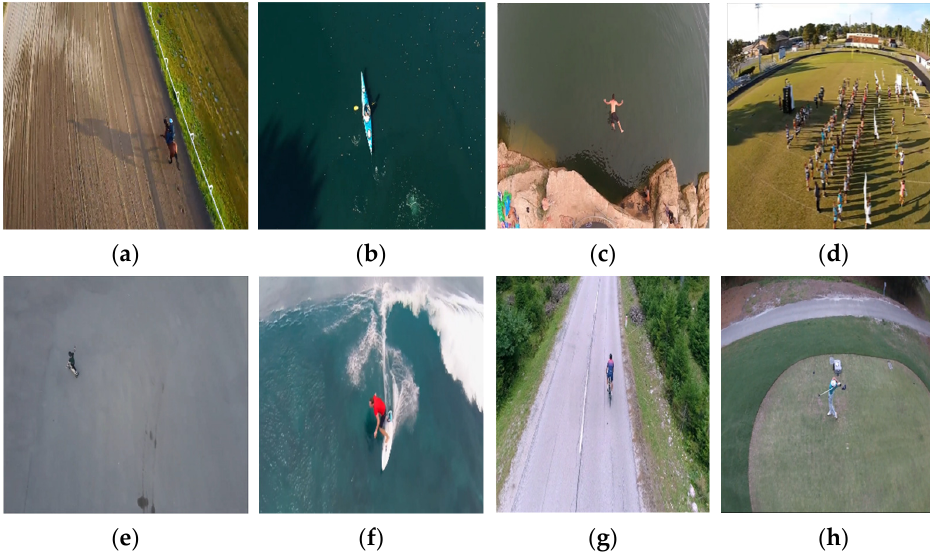
Figure 13. A few samples of the YouTube Aerial dataset, including ( a ) horse-back riding, ( b ) kayaking, ( c ) cliff-diving, ( d ) band marching, ( e ) skateboarding, ( f ) surfing, ( g ) cycling, and ( h ) golf.